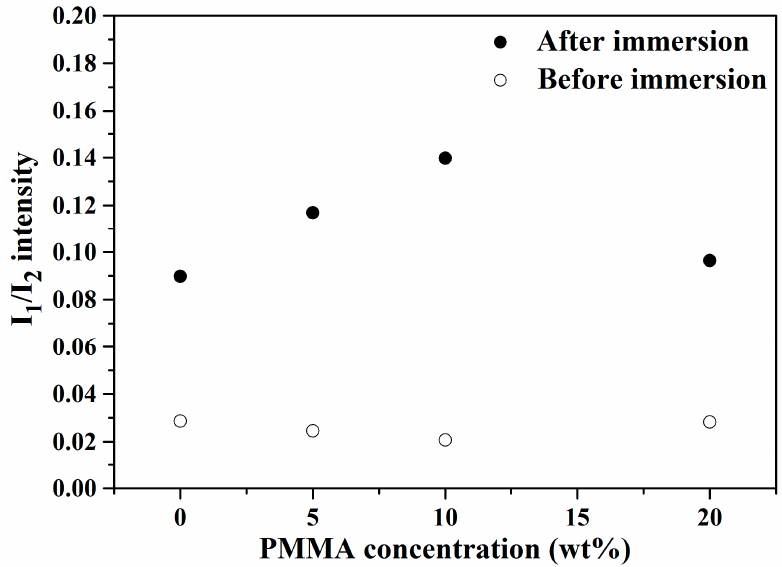
Figure 5. Computed I 1 /I 2 intensity of 0, 5, 10 and 20 wt.% PMMA–treated BG microspheres before and after SBF immersion.